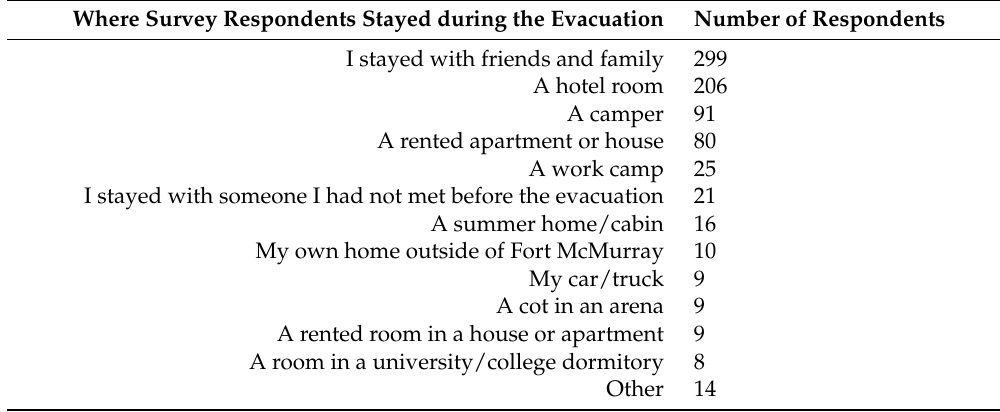
Table 6. Types of accommodation for survey respondents (n =